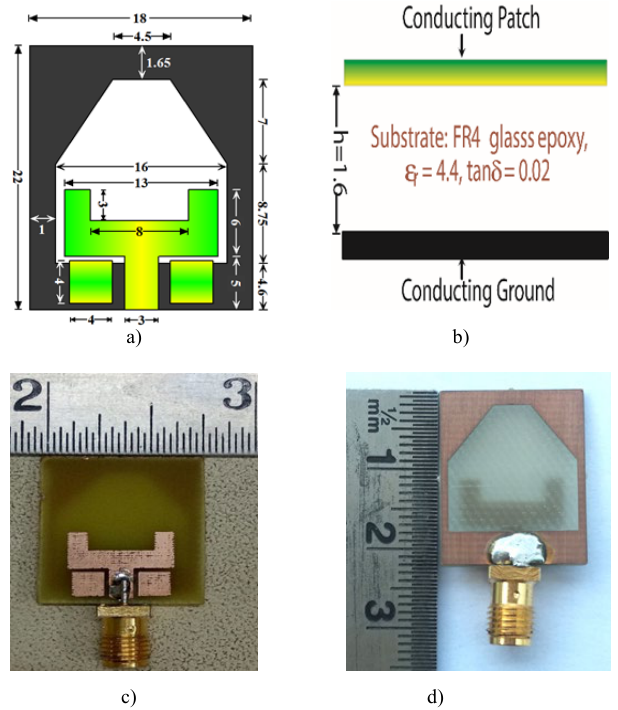
Fig. 1. Geometry of the proposed antenna (dimensions are in mm): a) Front view geometry of the proposed antenna; b) Side view geometry of the proposed antenna; c) Front view photograph of the proposed antenna; d) Back view photograph of proposed antenna.